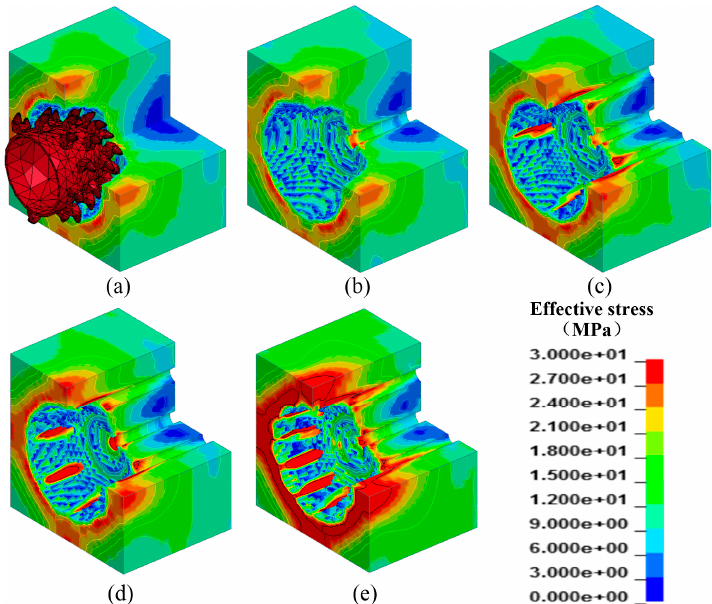
Figure 19. Von Mises effective stress contours of rocks containing different numbers of holes under confining pressure of 10 MPa: ( a ) no holes; ( b ) one hole; ( c ) five holes; ( d ) nine holes; and ( e ) 13 holes.